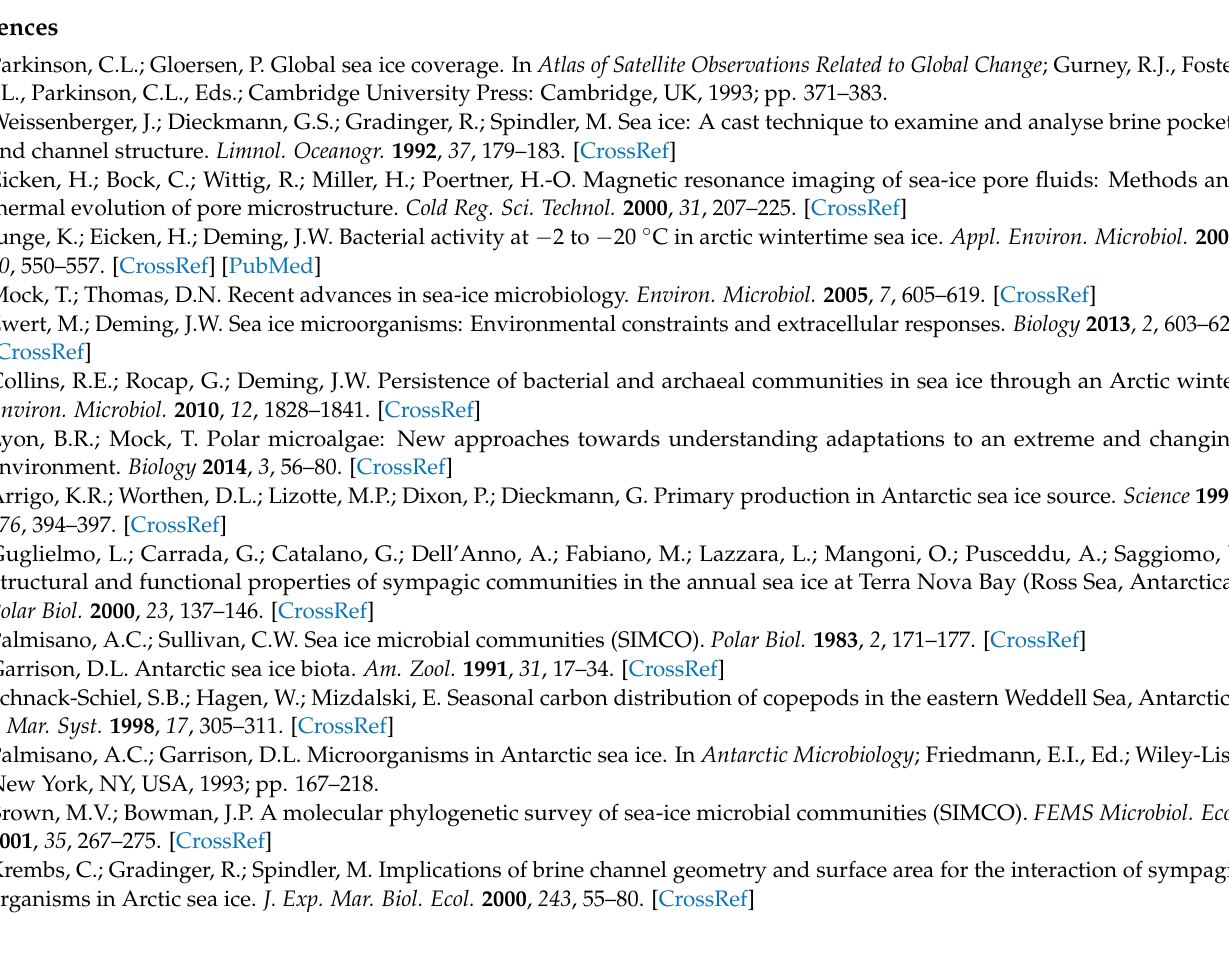
level) of microbial community observed in anaerobic enrichment decomposing compatible solutes (choline and DMS). Figure S1: Rarefaction curves plotting the number of observed ASVs as a function of the number of